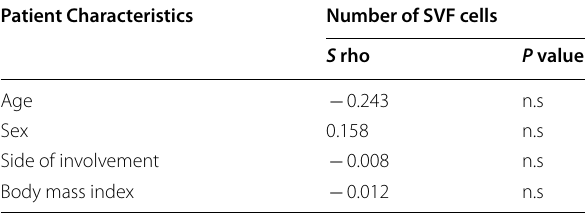
Data are calculated using the Spearman’s rank-order test SVF Stromal vascular fraction